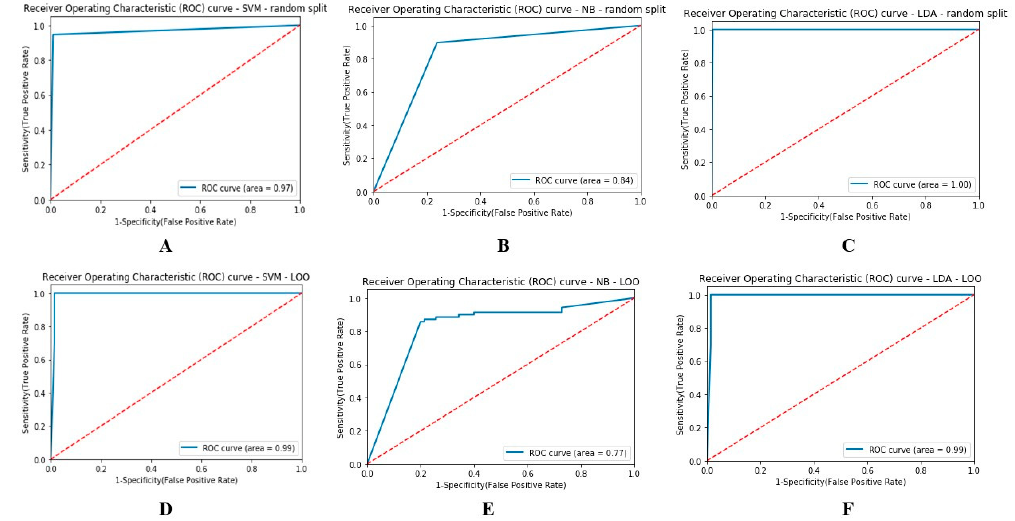
Figure 2. Receiver operating characteristic curve (ROC) of three classifiers, namely, support vector machine (SVM), Bayesian network (BN), and linear discriminant analysis (LDA), (simulated data) with different area under the curve (AUC) values: ( A,D ) SVM, ( B,E ) NB, and ( C,F ) LDA. The classifiers were evaluated through two different methods: ( A,B,C ) random split and ( D,E,F ) leave-one-out (LOO).